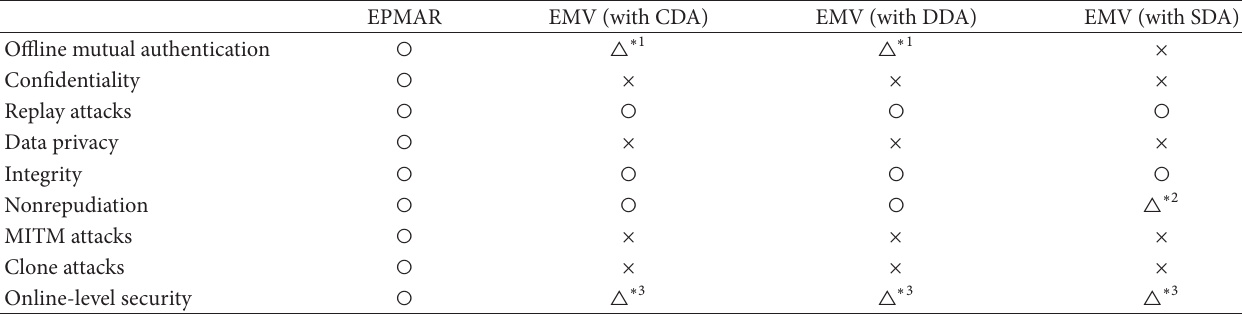
Table 1: Security comparison with current EMV protocols.